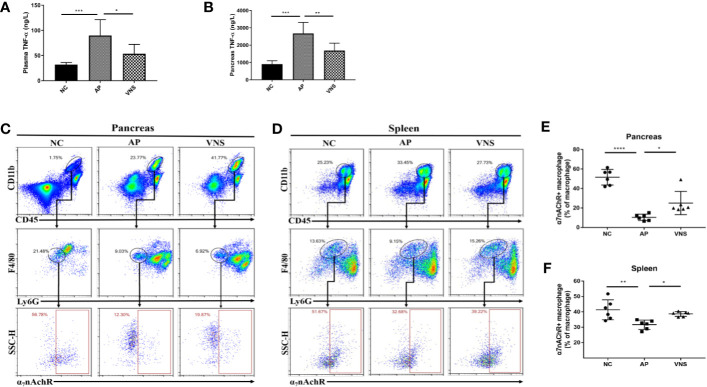
Vagus nerve stimulation decreases TNF-α levels and increases the frequency of α7nAChR+ macrophages in caerulein-induced pancreatitis. AP was induced by 8 hourly i.p. injection of caerulein and VNS was applied to mice 30 min after the first injection. Mice were harvested 2 h after the last injection. (A) Plasma TNF-α levels. (B) Pancreas TNF-α levels. Pancreatic and splenic leukocytes were isolated for flow cytometry. Leukocytes were gated (CD11b+CD45+). Macrophages were gated (CD11b+CD45+F4/80+Ly6G−) and analyzed for α7nAChR positive cell frequency. The percentages and representative flow cytometry plots illustrating α7nAChR+ macrophages in the pancreas (C, E) and the spleen (D, F). Data are shown as the means ± SE of 6 mice per group. *p < 0.05, **p < 0.01, ***p <; 0.001, ****p < 0.0001. VNS vagus nerve stimulation, NC normal control, AP acute pancreatitis.